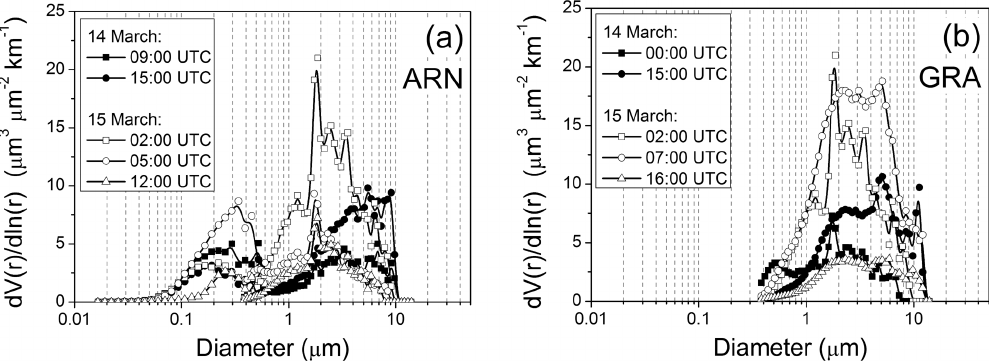
Fig. 12. Ground-level volume size distributions (VSD GL ) from in-situ measurements at selected times on 14 March (dusty day, full symbols) and 15 March (non-dusty day, open symbols) in ARN (a) and GRA (b)